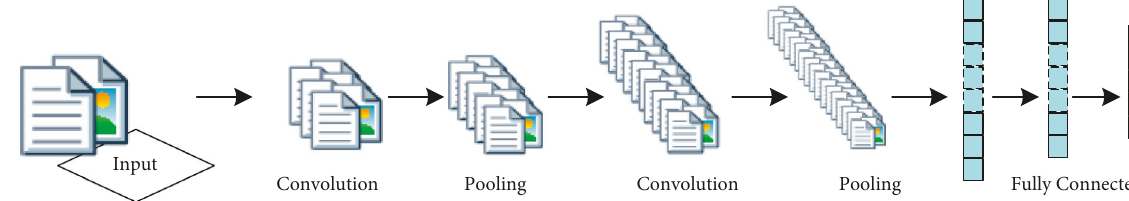
Figure 4: CNN network